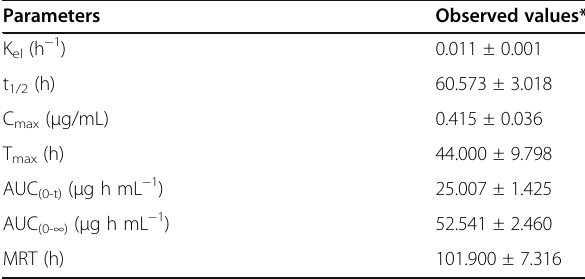
Table 4 Pharmacokinetic parameters of LTZ in SD rats